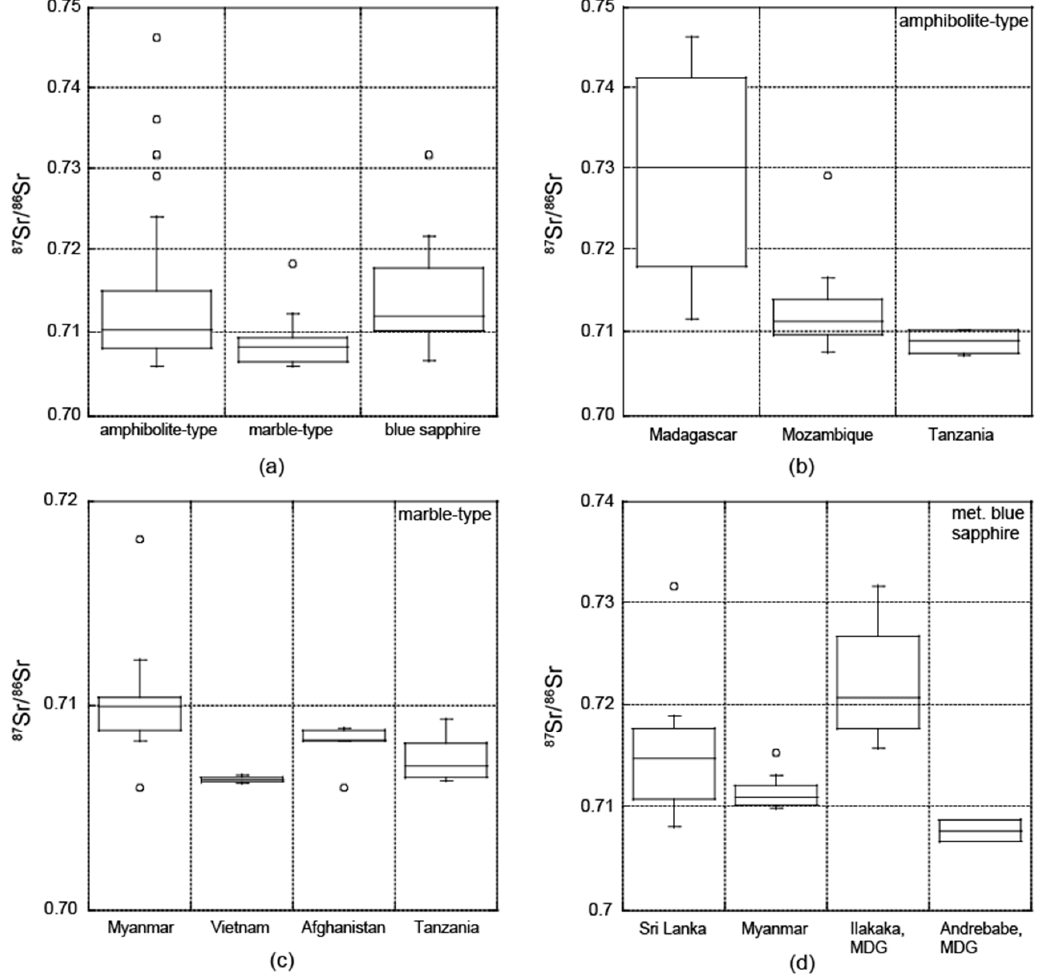
Figure 7. Box and whisker plots displaying 87 Sr / 86 Sr isotopic compositions of gem corundum from ( a ) the three different deposit groups, ( b ) the amphibolite-type ruby localities, ( c ) the marble-type ruby localities, and ( d ) the localities of metamorphic blue sapphire measured in this study. Individual data points are outliers whose value is either greater than UQ + 1.5 × IQD or less than LQ − 1.5 × IQD (where UQ = upper quartile, LQ = lower quartile, and IQD = inter quartile distance).